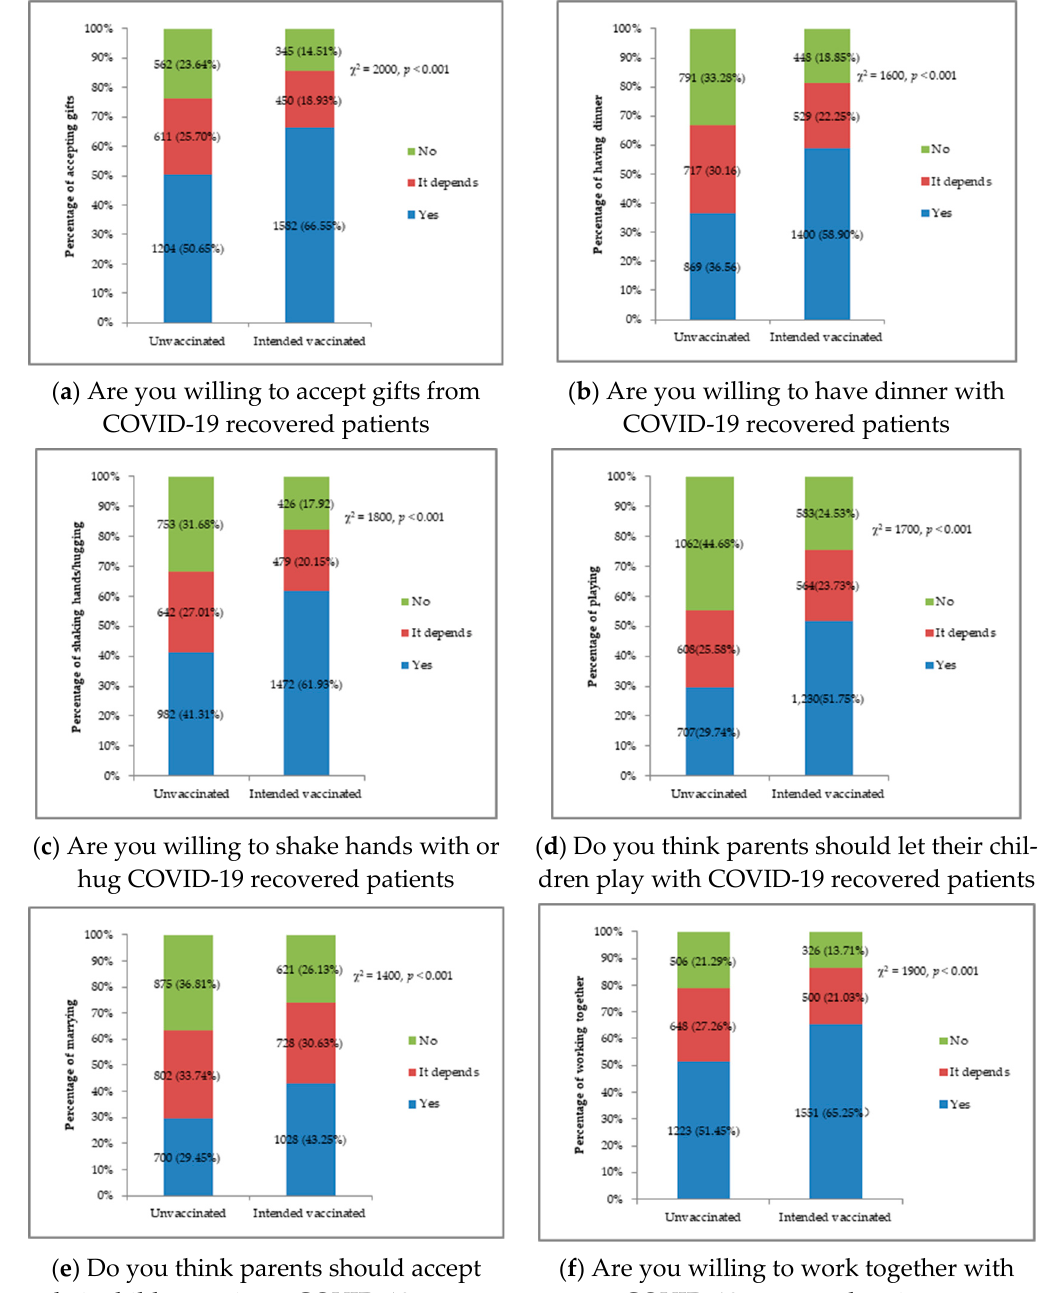
Figure 1. Discrimination level between unvaccinated and intended vaccinated respondents by each life event.